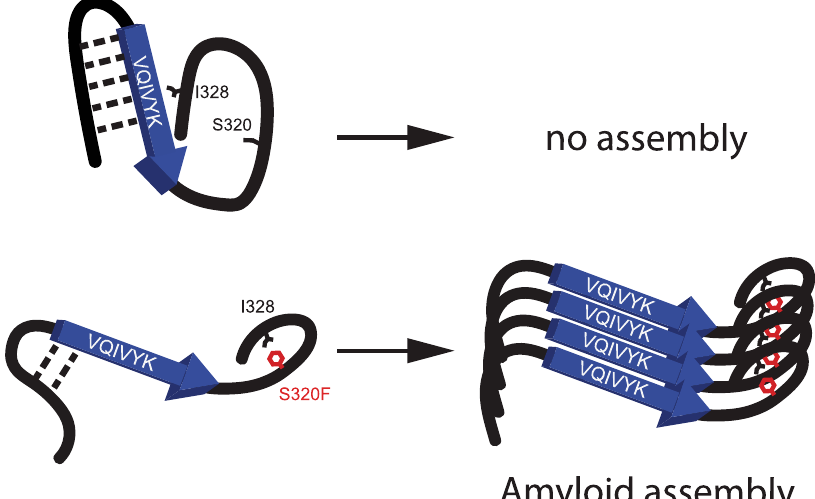
Fig. 6 | Molecular model of the structural differences between WT and S320F within region 295-330 of tau and their subsequent consequences. WT (top) forms a relatively collapsed structure surrounding the amyloid motif 306 VQIVYK 311 , where the sequence motifs at the end of repeat 2 and repeat 3 shield 306 VQIVYK 311 synergistically. In the S320F mutant, the sequence motif at the end of repeat 3 is